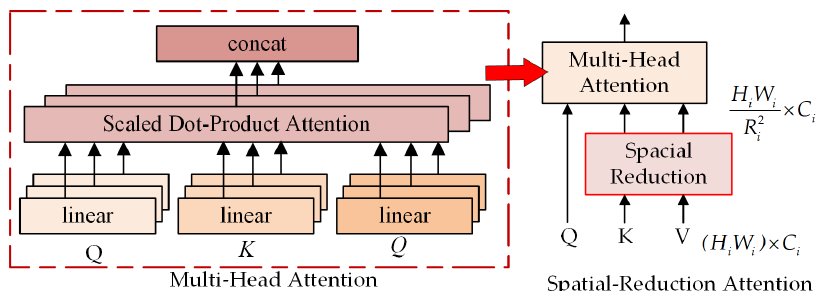
Figure 6. Spatial-Reduction Attention Mechanism.